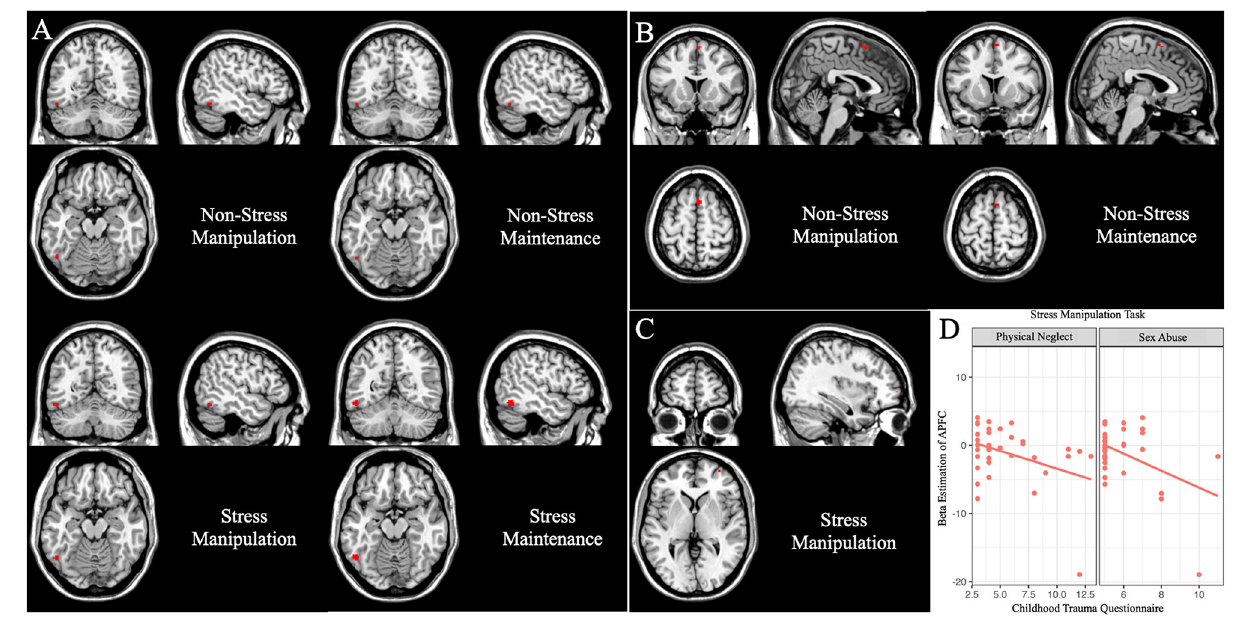
FIGURE 4 | Group differences under working memory maintenance and manipulation subtasks (data were controlling for age, p < 0.05, voxel-wise whole-brain FWE corrected). Main group differences under the working memory maintenance subtask. (A) The left fusiform gyrus showed decreased activation in MDD patients under the maintenance and manipulation conditions in stress and non-stress settings. (B) The right SMA exhibited reduced activation in MDD patients under the maintenance and manipulation conditions only in non-stress setting. (C) Under stress setting, MDD patients showed less activation in the right APFC in the manipulation condition. (D) In MDD group, and the β estimations of the right APFC peak voxel under stress manipulation subtask were negatively correlated with sex abuse ( r = − 0.43, p = 0.008) and physical neglect ( r = − 0.37, p = 0.026) score in the Childhood Trauma Questionnaire.